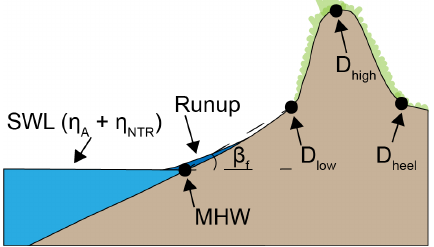
Figure 1. Schematic beach and dune profile showing the dune toe ( D low ), crest ( D high ), and heel ( D heel ), beach slope ( βf ), mean high water contour (MHW), still water level (SWL) and runup, modified from Sallenger